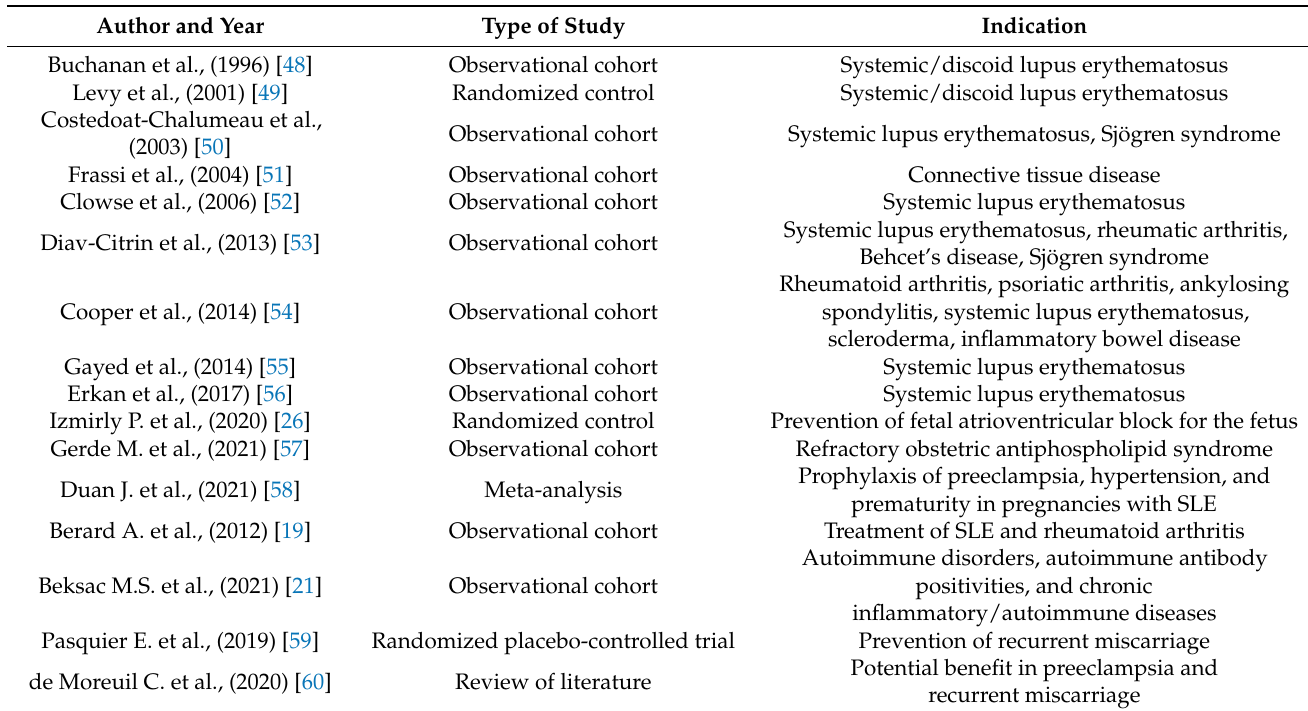
Table 2. Hydroxychloroquine and autoimmune disorders in